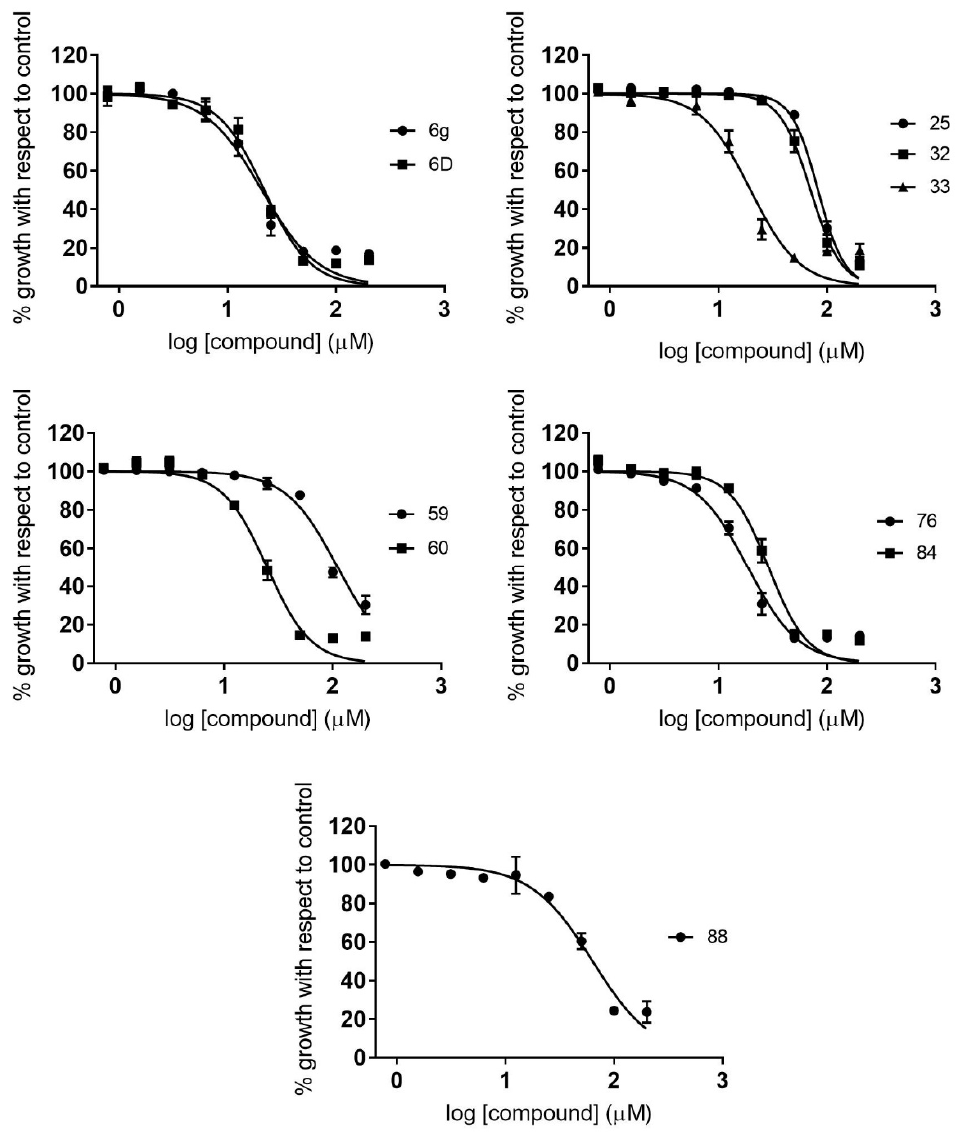
Figure 3. Dose–response curves of active compounds against P. falciparum , classified according to different structural groups (from A to E). Graphs represent mean values and SD results of at least three replicas.